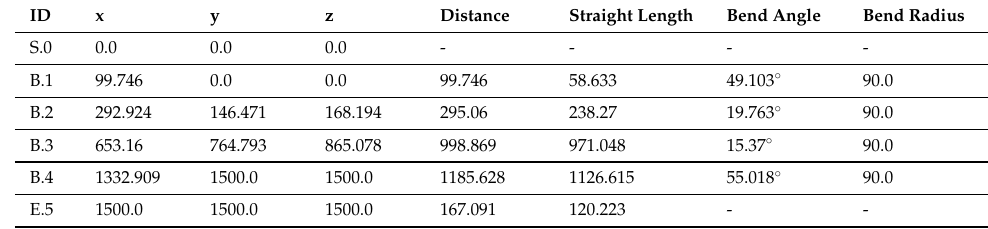
Table 1. Exemplary automatically generated bend